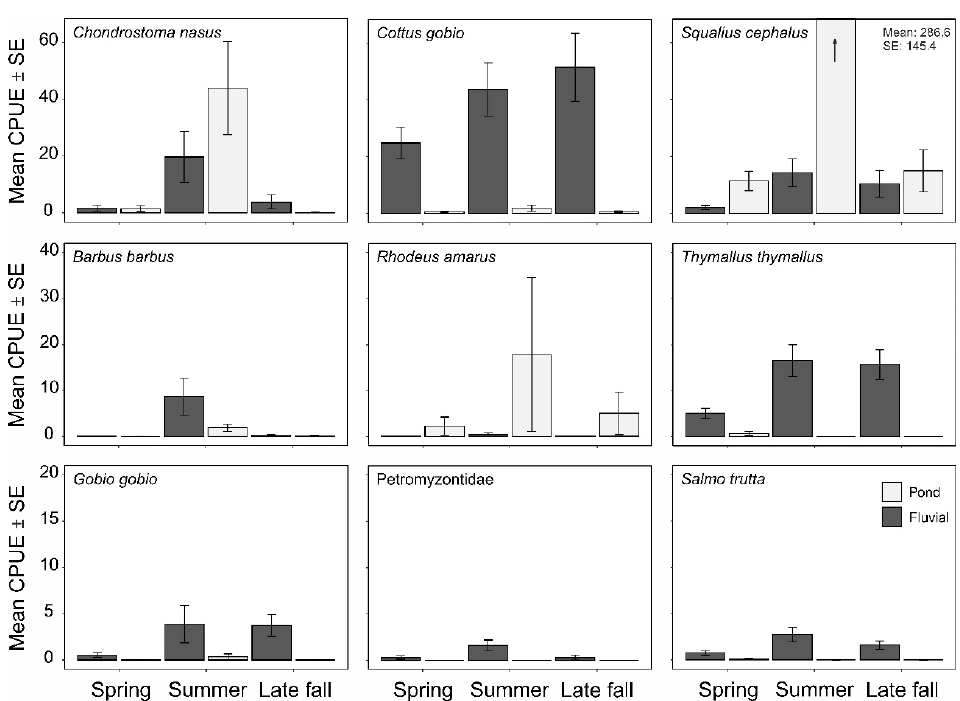
Figure 6. Seasonal distribution of the mean catch per unit effort ± standard error (CPUE ± SE) for selected target species of conservation. Different shades of grey indicate the habitat types ´pond´ (light grey) and ´fluvial habitat´ (dark grey). Outlier is marked with an arrow. Note the different scaling of the y-axis.